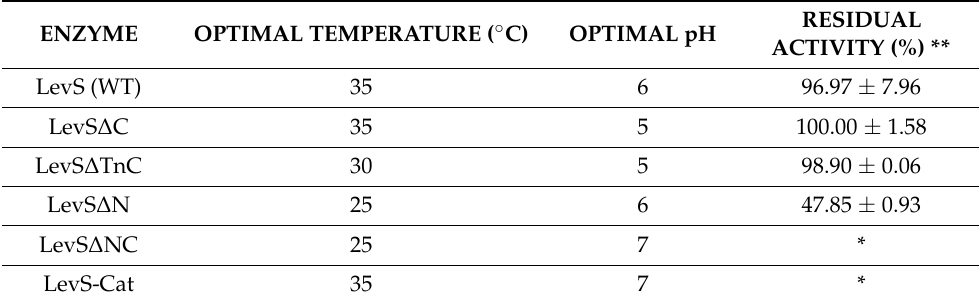
Table 2. Biochemical characterization of LevS and truncated versions.